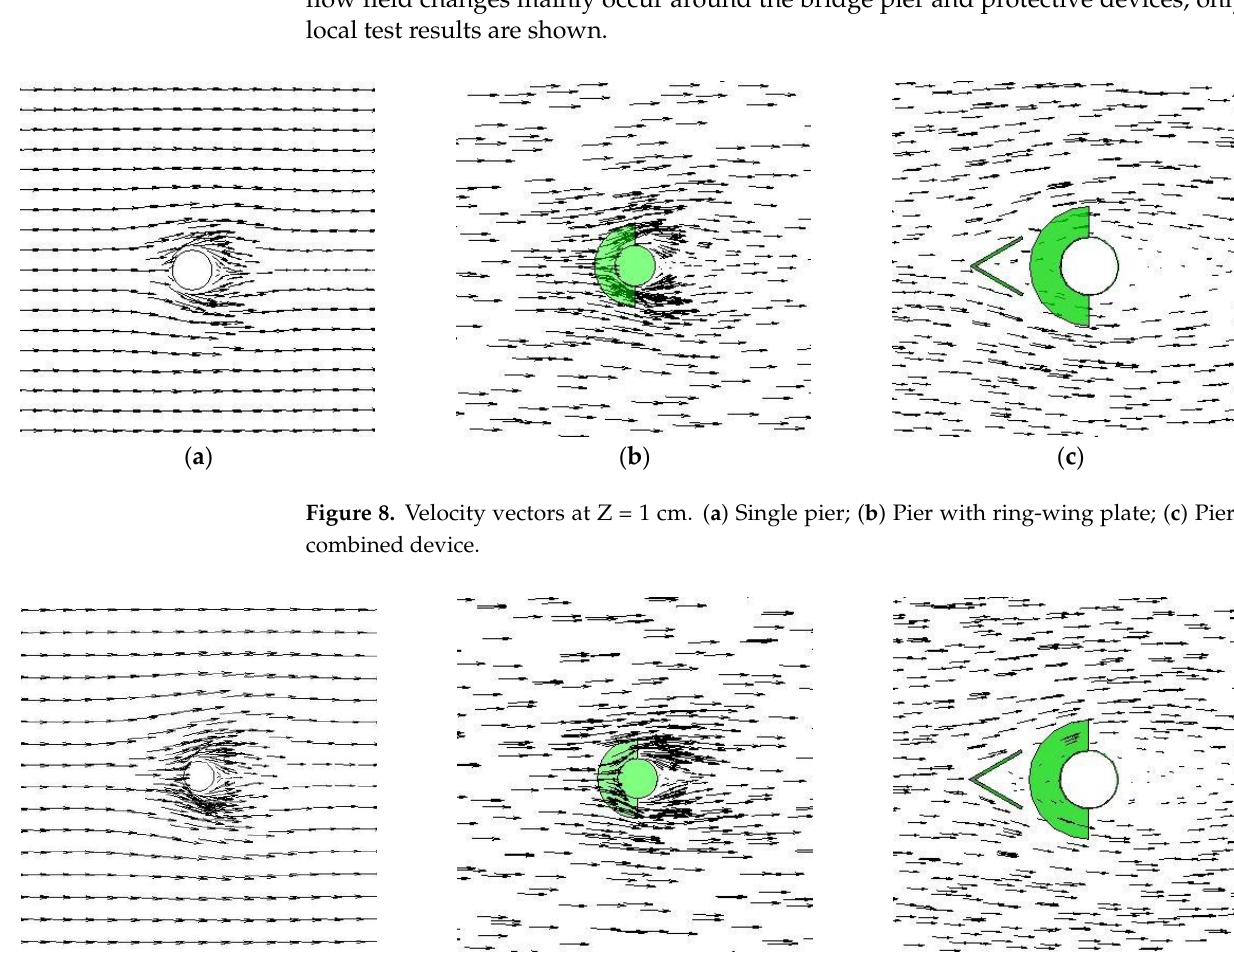
Figure 7. Scour depth and reduction rate.